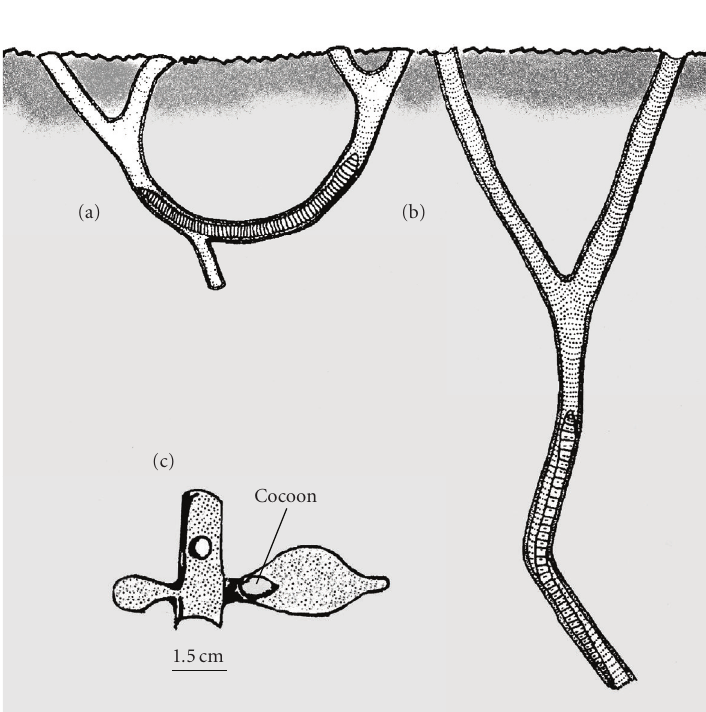
Figure 8: Schematic drawings of the burrows of juvenile (a) and adult (b) individuals of Lumbricus badensis . At depths of 40 to 150 cm below the soil surface, along burrows of adult L. badensis individuals, cocoon chambers with egg-capsules have been observed and documented (c). This indicates that parental investment is part of the reproductive strategy in this endemic earthworm species (adapted from